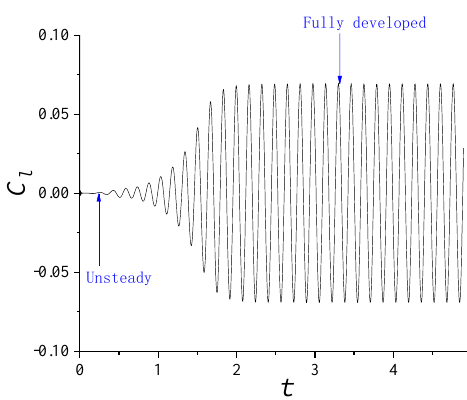
Figure 5. Convergence-time history curve of 𝐶 𝑙 .